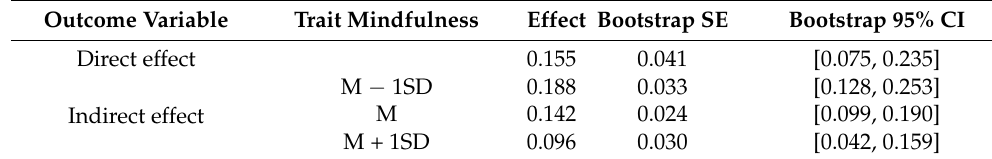
Figure 2. Simple slopes of the interaction effect: Trait mindfulness × Perfectionism (n = 425). Table 3. Standard total effect, direct effect, and indirect effect of perfectionism and social anxiety (n =